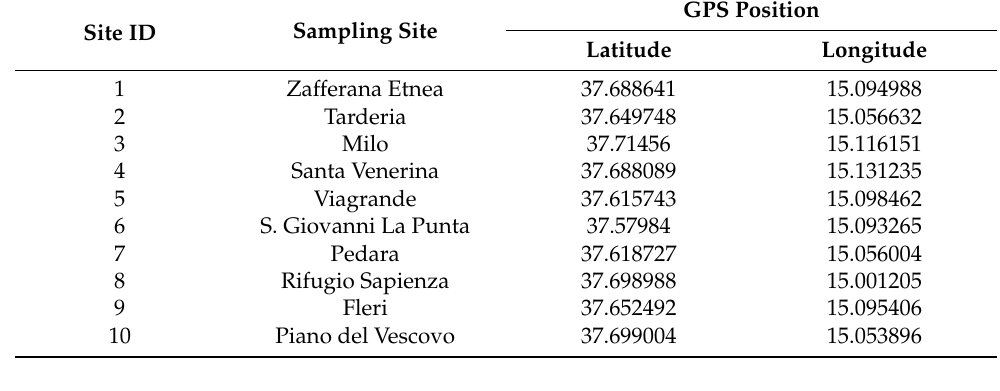
Table 1. Site IDs, locations, and GPS coordinates.